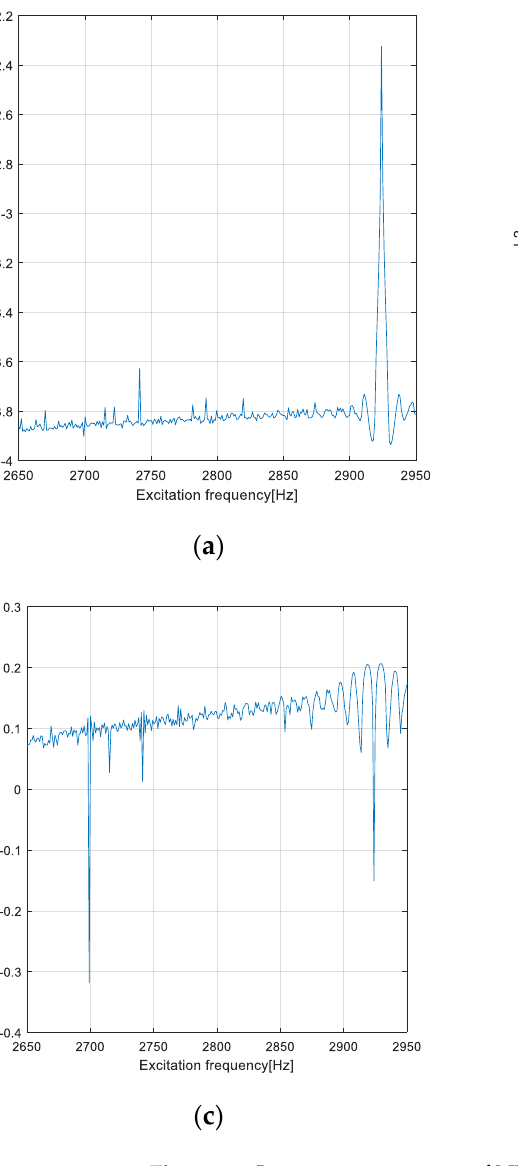
= 9 0 , ξ = 10.4 · 10 − 3 2